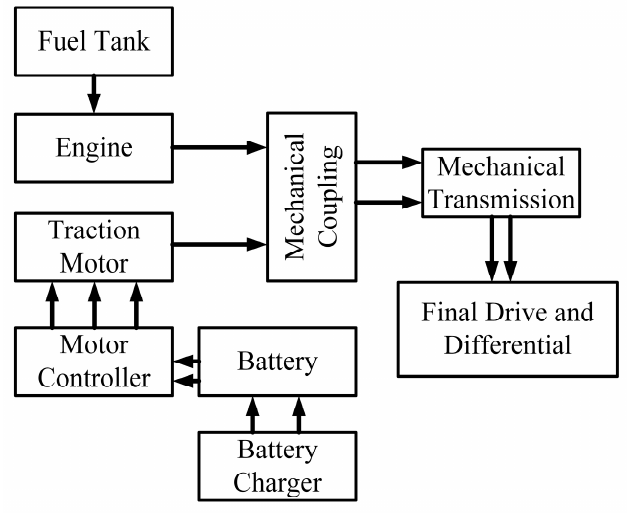
Figure 19. Drive train of parallel hybrid system. The engine and the motor both can run the can through the mechanical coupling [30]. Table 3. Advantages and limitations of parallel hybrid configuration. Adapted from [30].